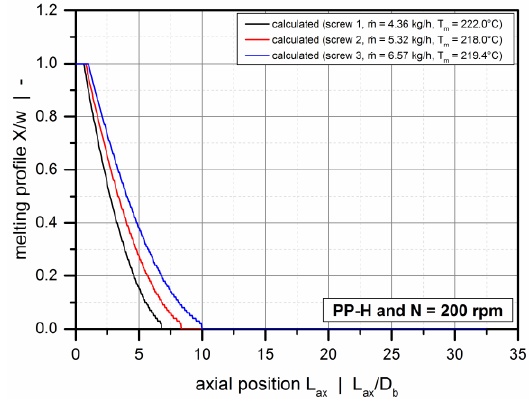
Figure A2. Calculated melting profiles for PP-H and N = 200 rpm.